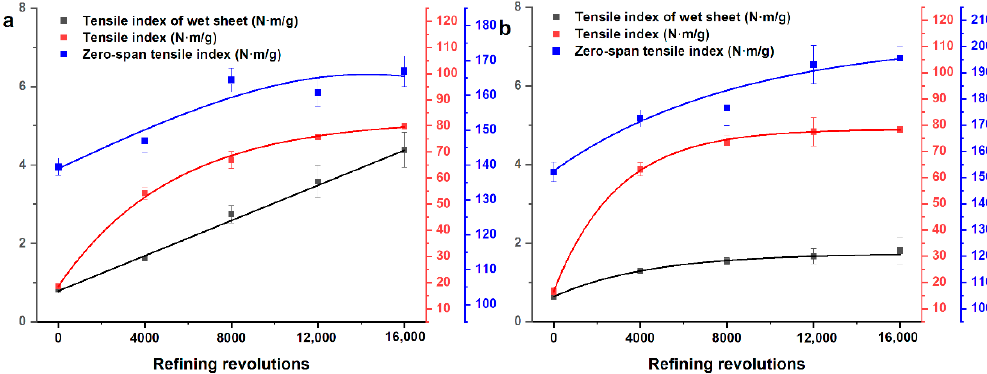
Figure 3. The rheological analysis of wet sheets, the tensile strength of dry sheets, and the fiber strength for unrefined and refined samples: ( a ) softwood fibers and ( b ) hardwood fibers.